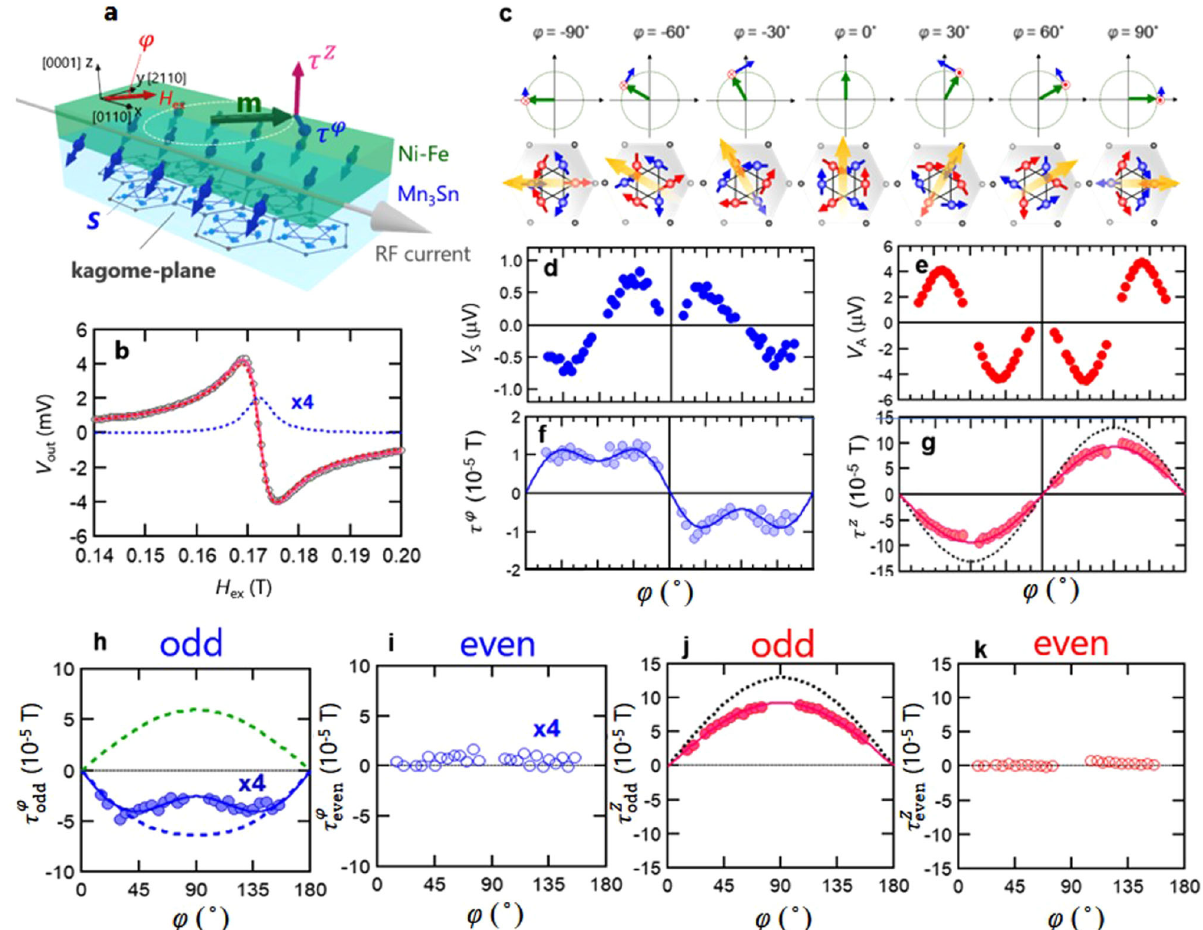
Fig. 2 Spin-torque FMR measurements in a Mn 3 Sn/Ni-Fe bilayer. a Measurement setup for spin-torque FMR measurement (ST-FMR). The red and blue arrows on the respective top and bottom surface of the Mn 3 Sn stack indicates spin accumulation. b ST-FMR spectrum. c (Upper) Magnetization of Ni-Fe (green arrows) and detected in-plane torque τ φ (blue arrows) and out-of-plane torque τ Z (red) in Mn 3 Sn/Ni-Fe bilayer system; (Lower) Spin structure of Mn 3 Sn and cluster magnetic octupole (orange arrows). d , e In-plane magnetic fi eld angle dependence of symmetric voltage V S and Anti- symmetric voltages V A . f , g In-plane torque τ φ and out-of-plane torque τ Z . h , i odd- and even-component of τ φ under reversal of the ferromagnetic magnetization m . Green (Black) dashed line corresponds to τ φ due to conventional SHE (MSHE). j , k Odd- and even-component of τ z . Black dashed line corresponds to τ z due to Oersted fi